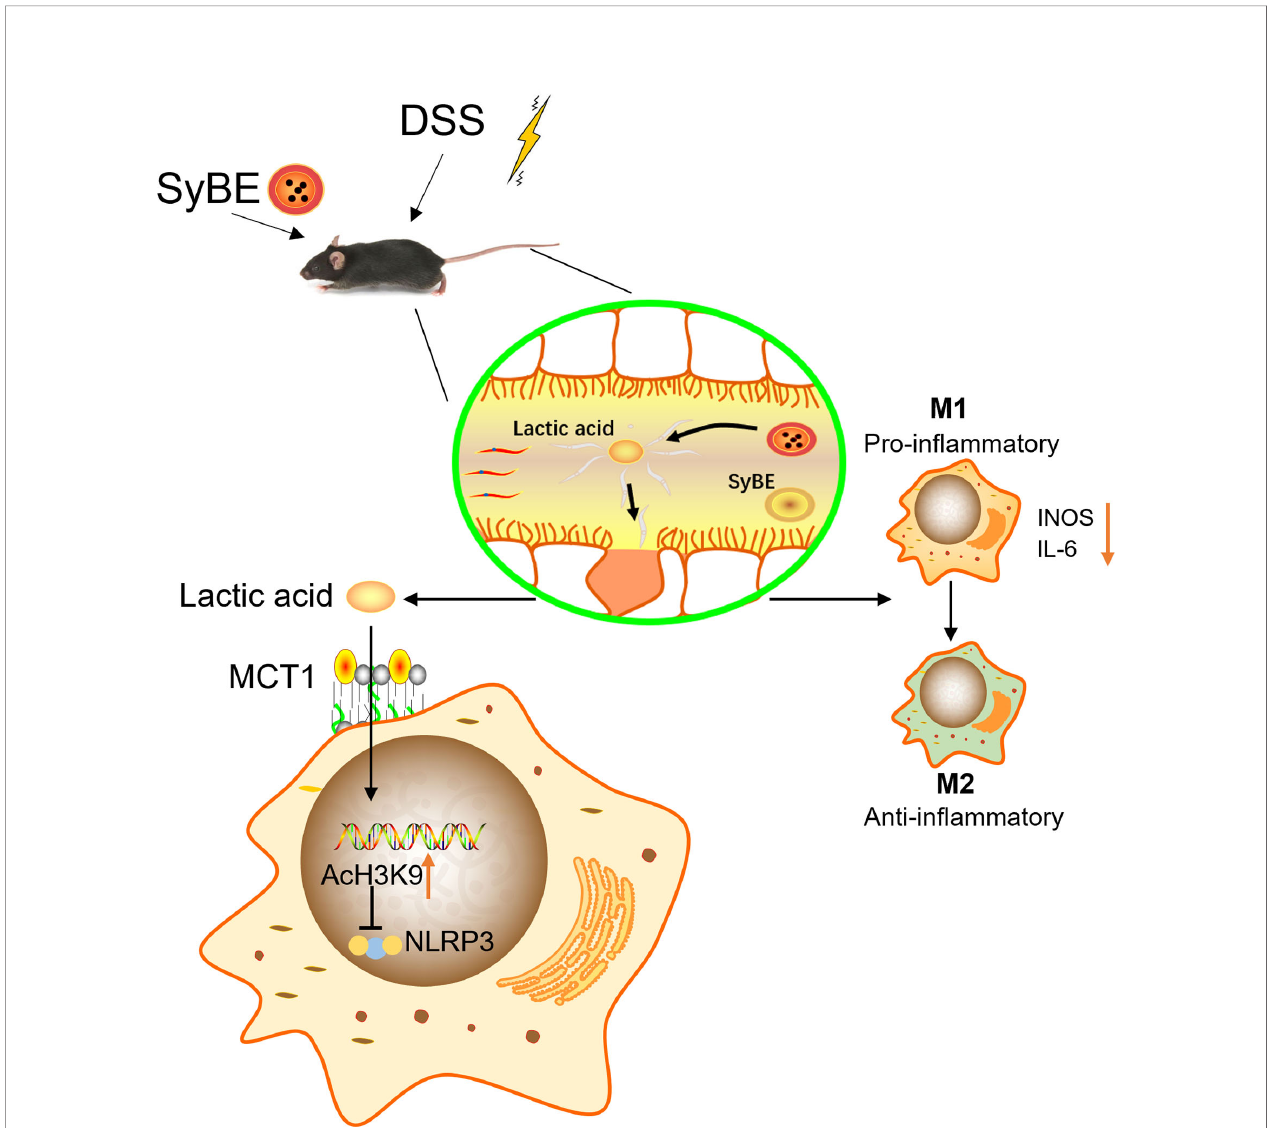
FIGURE 9 | Lactic Acid-Producing probiotic Saccharomyces cerevisiae (SyBE) attenuates DSS-induced mice colitis via suppressing macrophage pyroptosis and modulating gut microbiota. Additionally, SyBE modulated the macrophage polarization state in colitis. SyBE: Saccharomyces cerevisiae . MCT1: monocarboxylic acid transporter 1. DSS, dextran sulphate